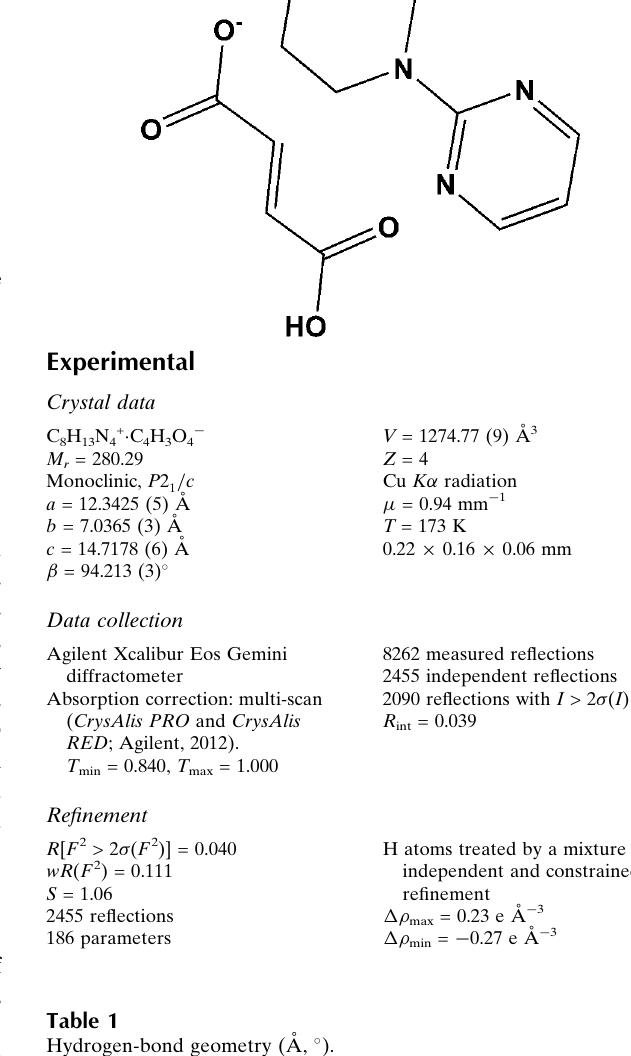
Hydrogen-bond geometry (A˚ , (cid:4)